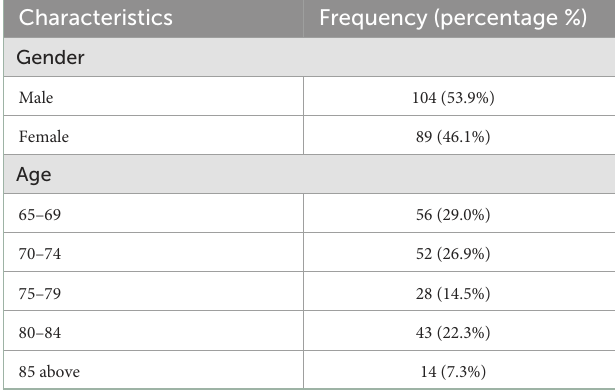
TABLE 3 Demographics of the selected